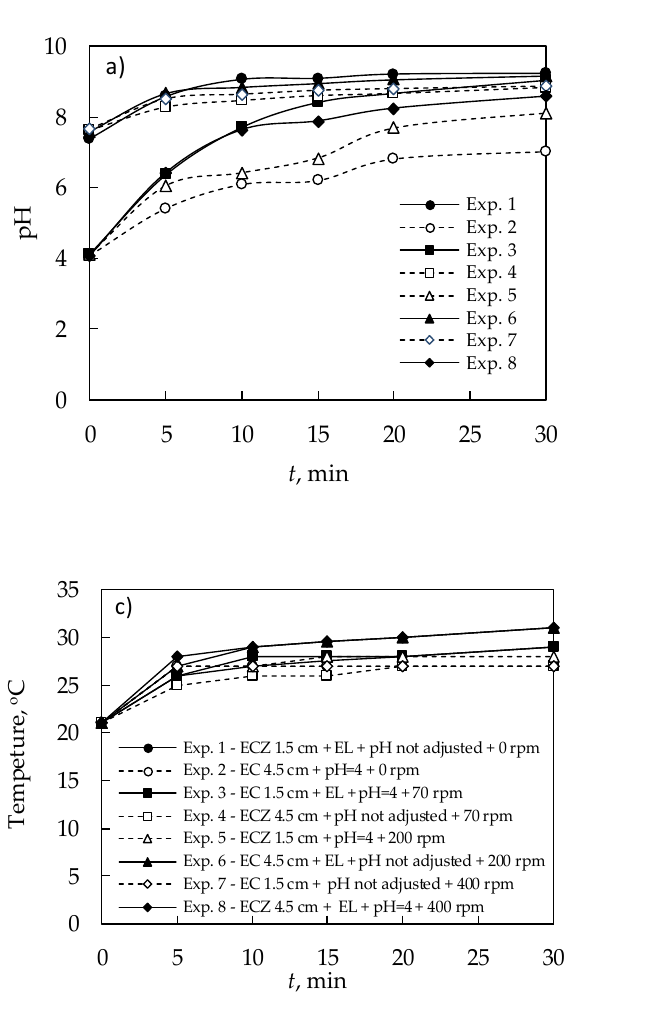
Figure 5. Change of pH ( a ), el. conductivity ( b ), temperature ( c ), total solids ( d ) during eight experiments of the electrocoagulation process with and without the addition of zeolite (EC vs. ECZ) at different electrode distances (1.5 and 4.5 cm), the addition of electrolyte NaCl (EL), solution initial pH adjustment (pH = 4 and without pH adjustment) and steering speed (0, 70, 200, and 400 rpm). Note: description of experimental conditions during eight experiments are given in legend of Figure 5c and Table 2.